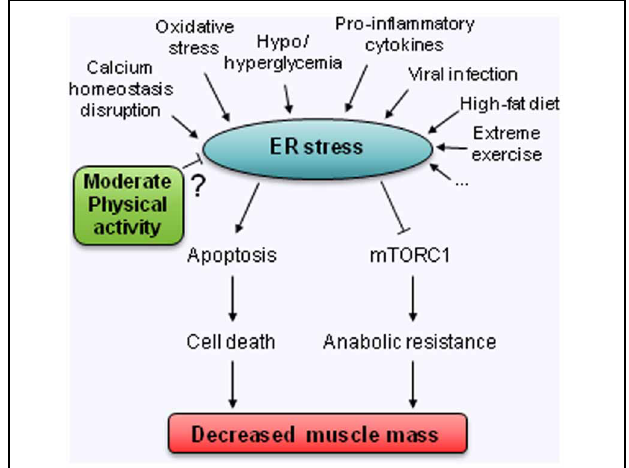
FIGURE 1 | Hypothetical model for the involvement of ER stress in the decreased muscle mass observed with age. ? means untested